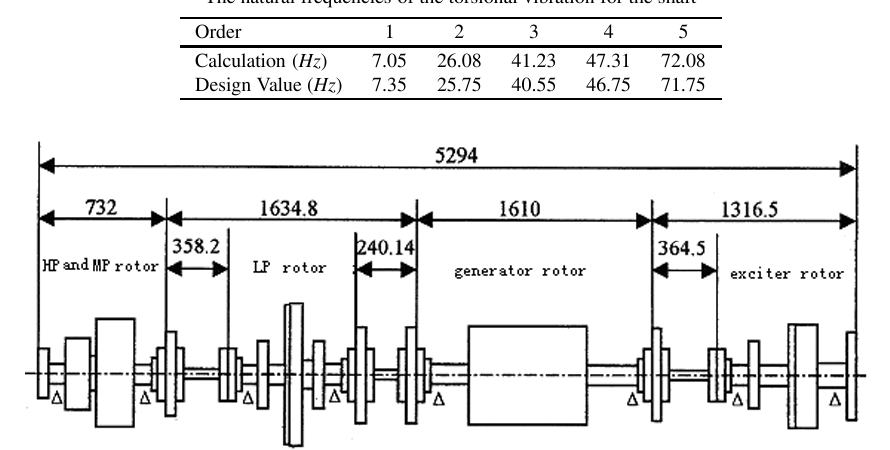
Fig. 3. The shaft structure of a turbo-generator, length unit: mm.